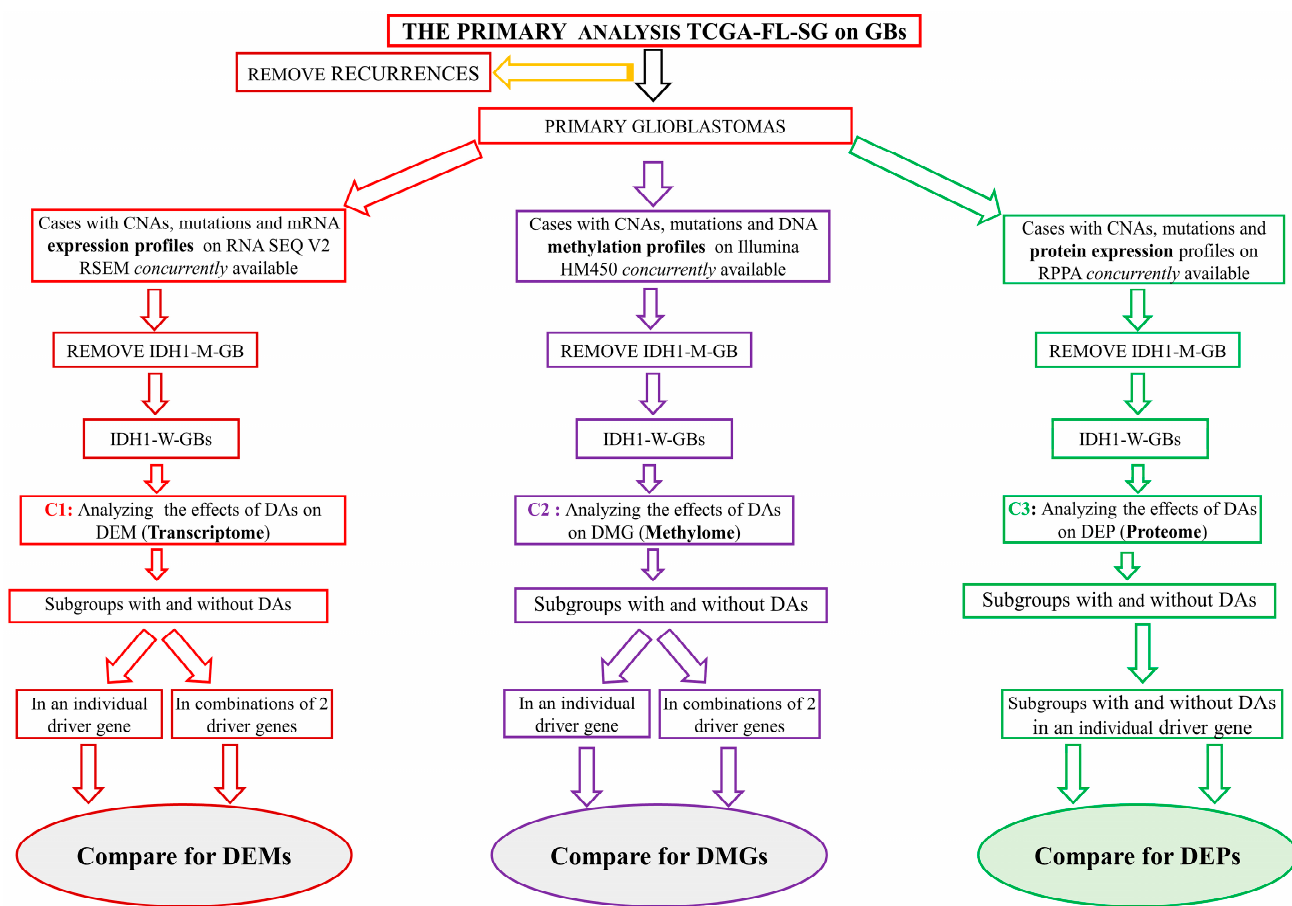
Figure 1. Workflow of the primary analyses performed on TCGA-FL-SG on GBs. Recurrent tumors were removed, and groups were created based on the availability of the required test profile to enable necessary analyses. IDH1-W-GBs were removed to create three core groups: C1, C2 and C3. The workflow for DEMs is indicated with a red color scheme, the one for DMG has a purple color scheme and the one for DEP has a green color scheme. TCGA-FL-SG: The Cancer Genome Atlas Study Group; GBs: Glioblastomas; IDH1-M-GB: IDH1 mutant glioblastoma; IDH1-W-GB: IDH1 wildtype glioblastoma; DA: Driver alteration; CNA: Copy number alteration; DEM: Differentially expressed mRNAs; DMG: Differentially methylated genes; DEP: Differentially expressed proteins; RNA seq v2 RSEM: RNA sequencing platform V2 and analyzed with RNA sequencing by Expectation Maximization (RSEM) software package (Version v 1.3).